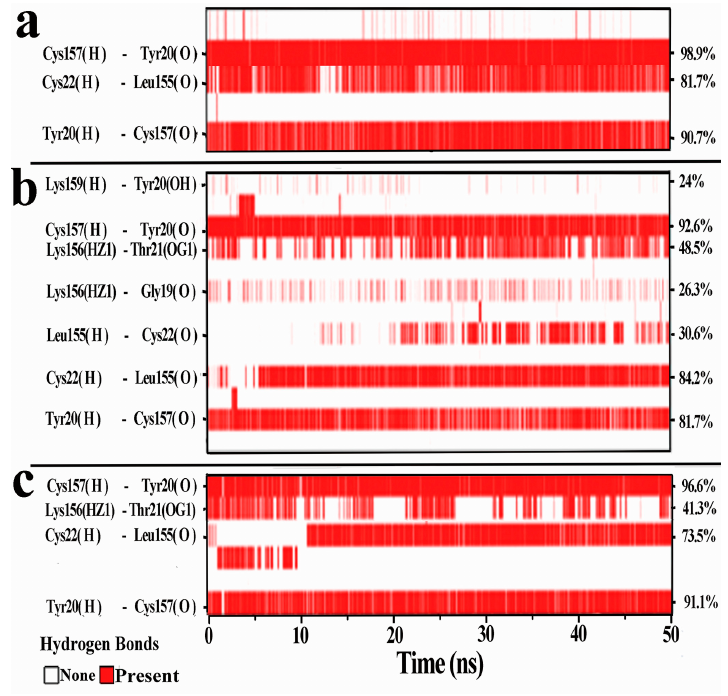
Figure 5. Hydrogen bond existence map between residues of β 6 and β 7. The red band shows the existence of hydrogen bonds while the white band shows the absence of hydrogen bonds. Donor/acceptor pairs are shown for ( a ) APO-TP; ( b ) Cu(II)-TP; and ( c ) Inhibitor-TP systems. Only hydrogen-bond pairs that have an incidence greater than 20% in the WT system are shown.